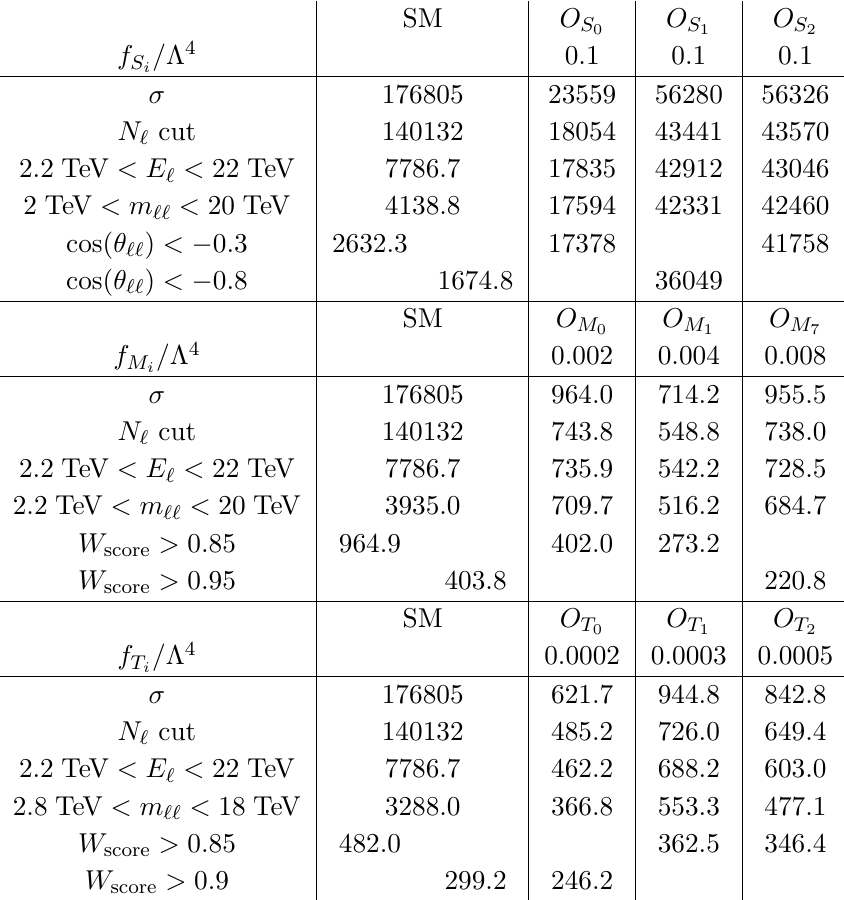
Table 5 . Cross-sections (ab) after cuts at